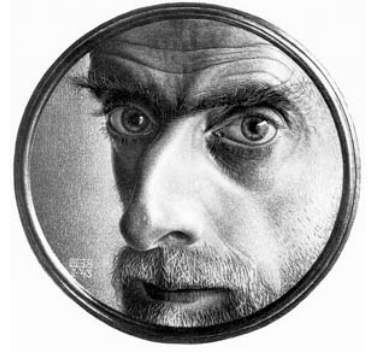
Figure 1. M. C. Escher, Selfportrait , 1943.